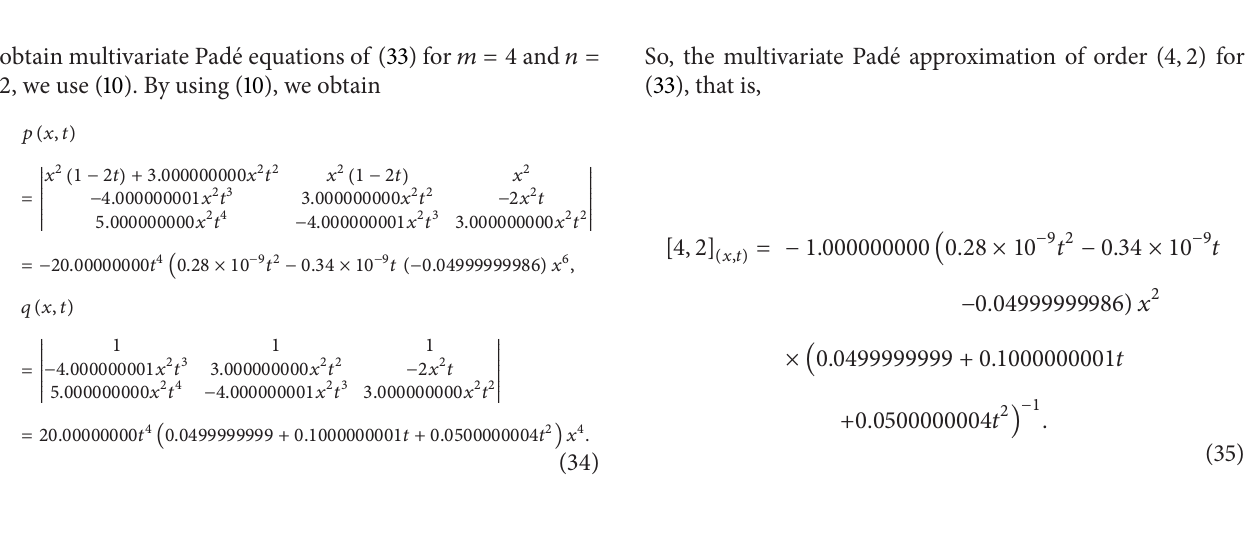
Figure 3: (a) Exact solution of Example 2 for 𝛼 = 2.0 (b) ADM solution of Example 2 for 𝛼 = 2.0 (c) Multivariate Pad´e approximation of ADM solution for 𝛼 = 2.0 in Example